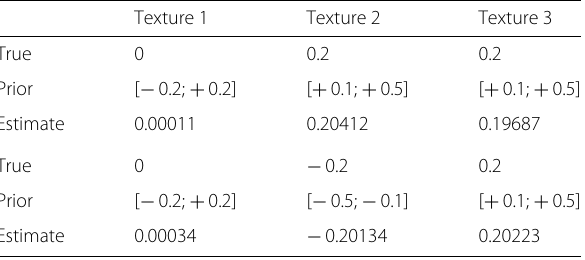
and ν 0 are x y